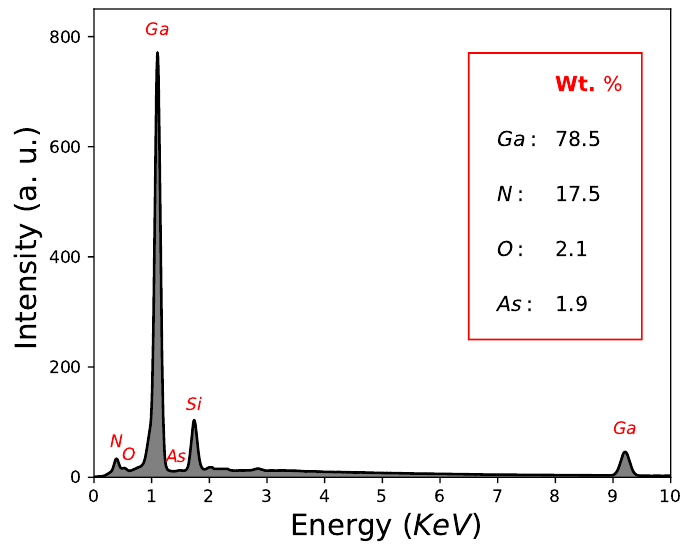
Figure 6. Elemental composition via EDS of sample